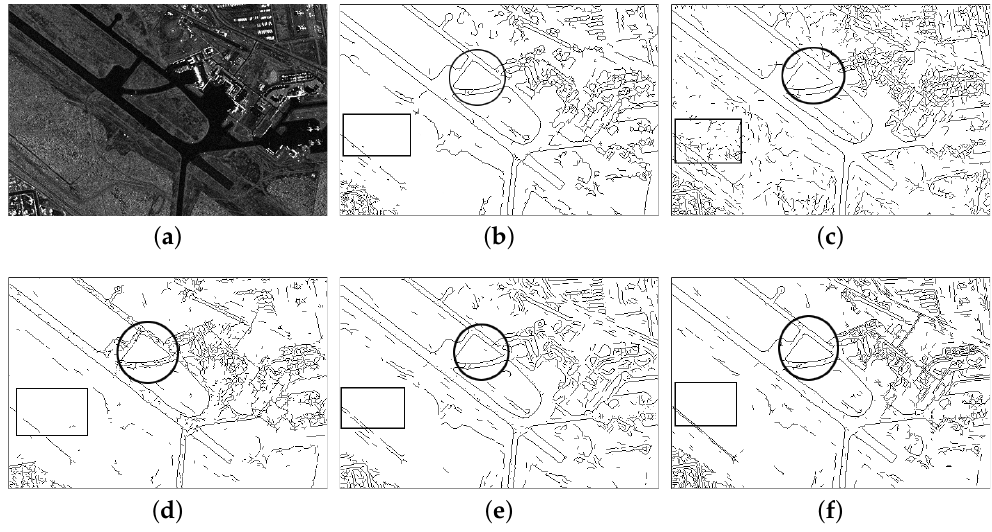
Figure 18. Results on the third satellite SAR image. ( a ) The raw image; ( b ) SAR-PC; ( c ) PC; ( d ) Log-PC; ( e ) RBED; ( f )